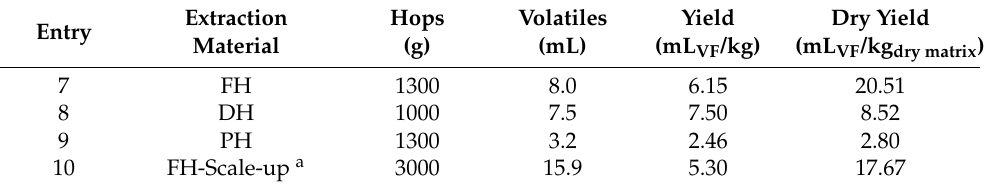
Table 5. MAHD, mild irradiation protocol and 12 L vessel scale-up. L/S ratio: 1